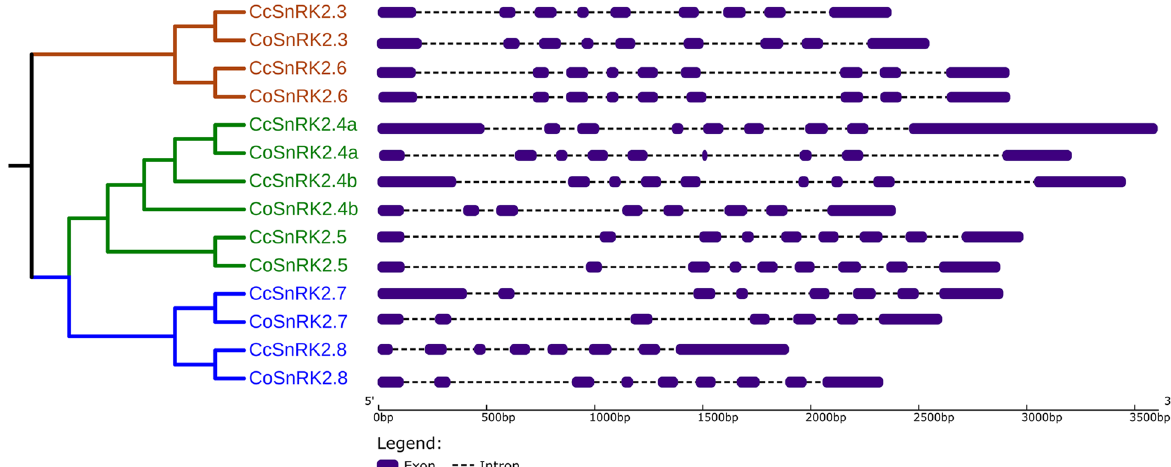
Fig. 3 Exon–intron structure of 14 SnRK2s genes of C. olitorius and C. capsularis according to the phylogenetic tree. A graphic representation of the gene model was identified in this study. Exons are shown as dark blue boxes and introns are shown as brown dot